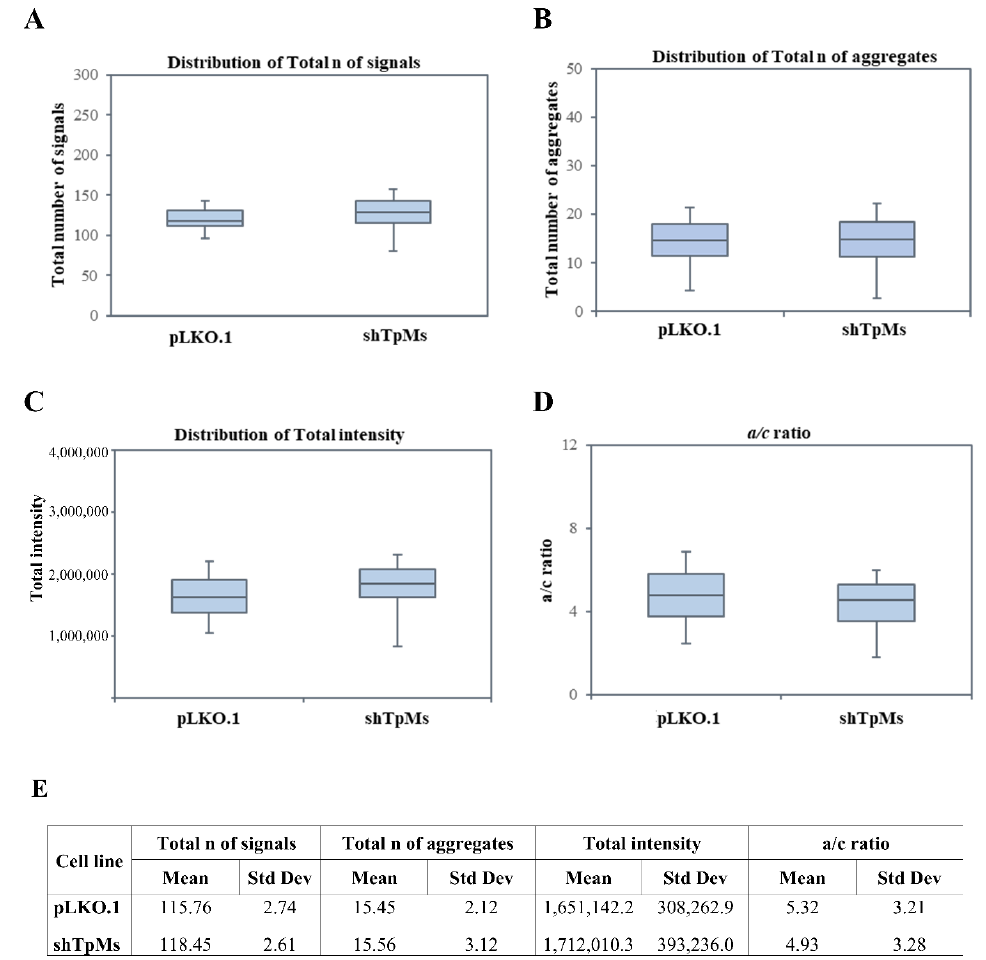
Figure 3. Loss of TpMs in PNT1A cells does not induce telomere dysfunction. Analysis of 3D nuclear telomere using TeloView in TpMs-depleted cells does not show significant differences in distribution of total number of signals ( A ); distribution of total number of aggregates ( B ); distribution of total intensity ( C ); and distribution of a/c ratio ( p = 0.0129) ( D ) compared with control cells (pLKO.1). ( E ) Mean = average of three different experiments; Std Dev = standard deviation.